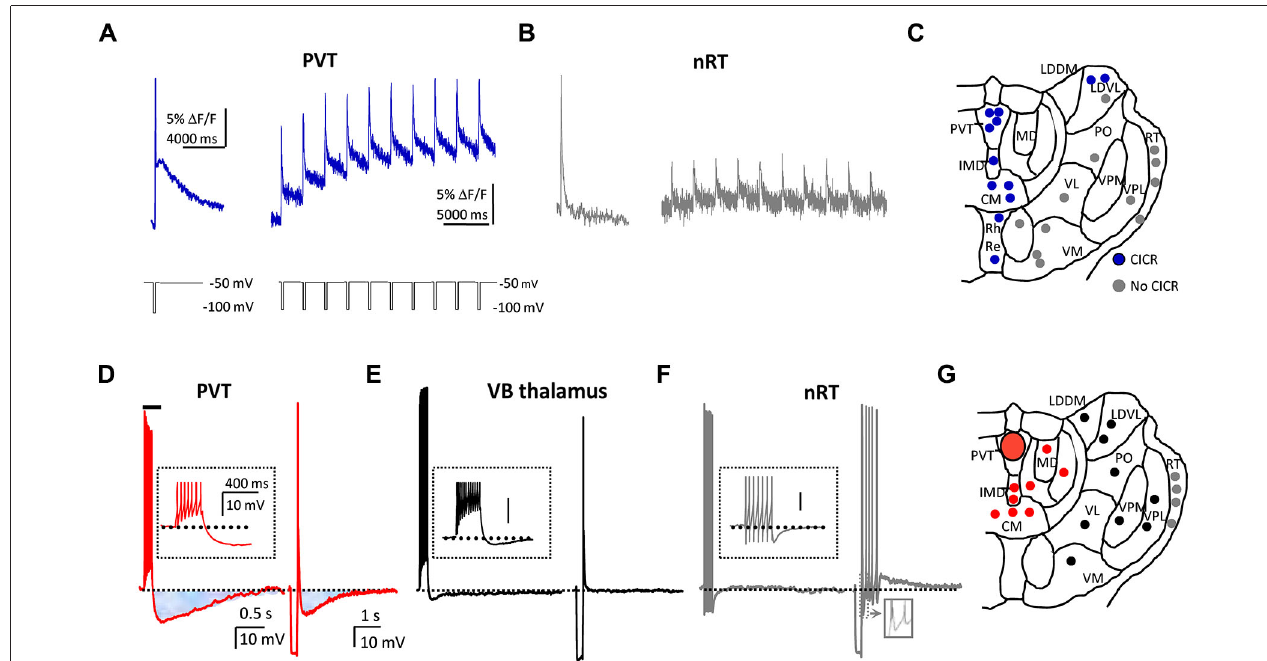
activation of T-type Ca 2 + channels. Abbreviations and scheme are based on the rat atlas by Paxinos and Watson (1998) (Reproduced in part with permission from Richter et al., 2005). (D) Voltage traces from the same PVT neuron illustrate a spike train-induced (left) and an LTS-induced (right) sAHP (shaded areas). (E, F) Using similar protocols, representative traces indicate that similar sAHPs are not observed in ventrobasal (VB; black trace and symbols) or reticular thalamic (nRT; gray trace and symbols) neurons. (G) Distribution of tested neurons to depict that only cells in midline and intralaminar thalamus displayed sAHPs (red circles). Abbreviations and scheme are based on the rat atlas by Paxinos and Watson (1998) (Reproduced in part with permission from Zhang et al.,